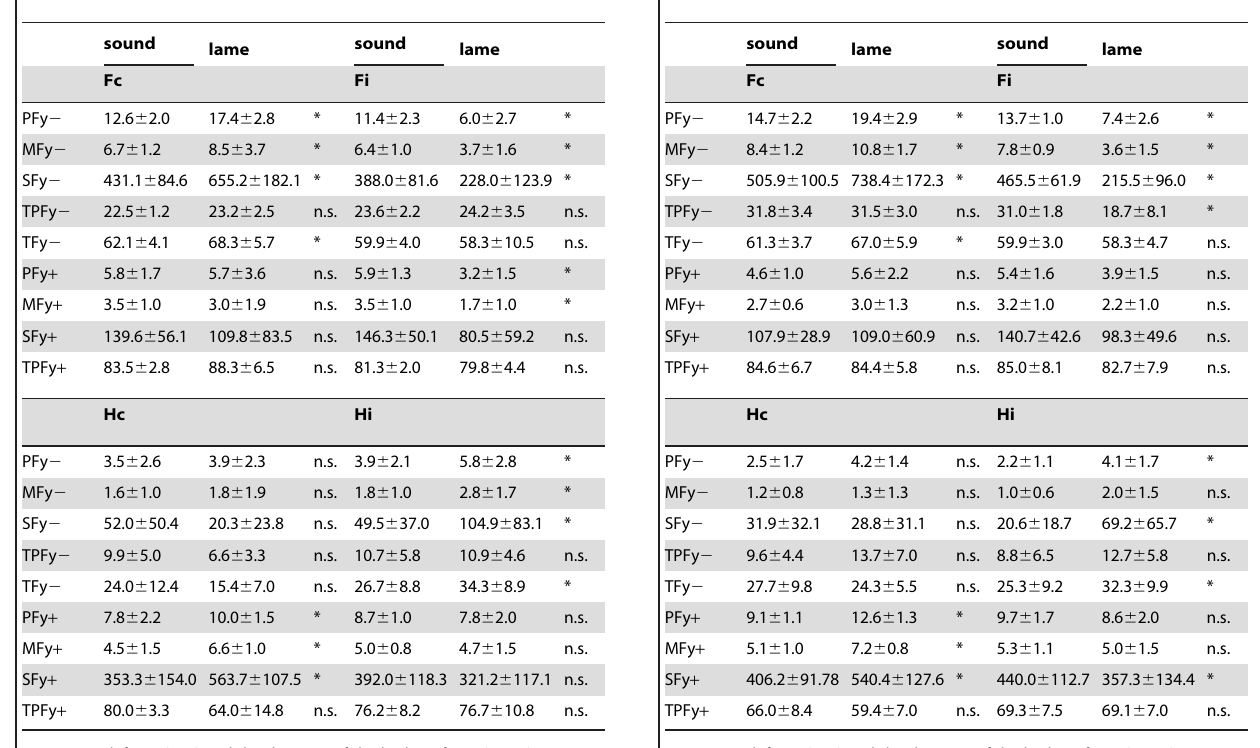
Figure 2. Fore-aft force profiles. Mean fore-aft forces (Fy in %BW) and SD (error bars) relative to stance duration in the sound dogs (black) and when lameness was induced (gray) in the ipsilateral forelimb (Fi) during walking (A) and trotting (B). The arrow indicates the only significant shift in the timing of PFy (p , 0.05). The stars indicate significant shifts in the timing of the transition from braking to propulsive forces (p , 0.05, see Tables 1 and 2 for the respective values). Fi=ipsilateral forelimb, Fc=contralateral forelimb, Hi=ipsilateral hindlimb, Hc=contralateral hindlimb.